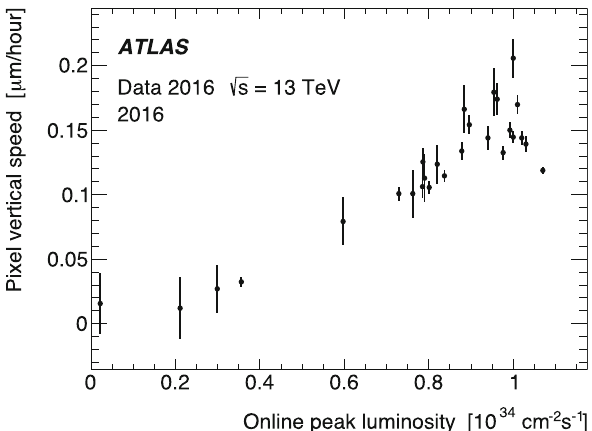
Fig. 9 Vertical speed of the Pixel detector as a function of the peak luminosity of an LHC fill, extracted from alignment corrections. Only fills longer than 8 h are